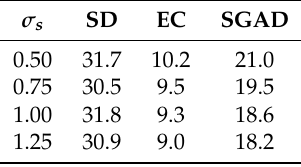
Table 1. Processing times of SD-, EC-, and SGAD-based methods for simulated images (in seconds). σ s